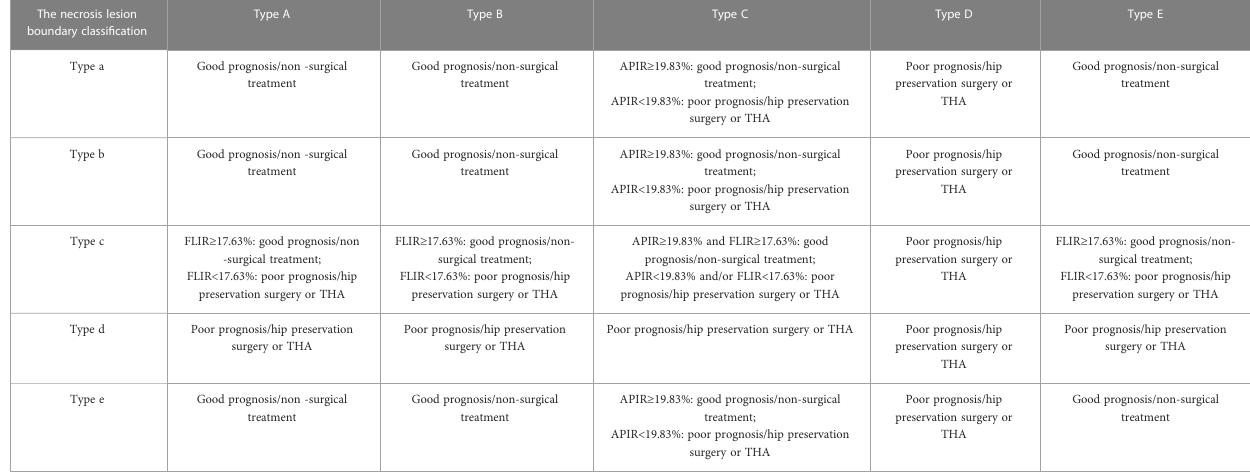
TABLE 6 The prognosis prediction and treatment for the necrosis lesion boundary classi fi cation. Thenecrosis lesion boundary classi fi